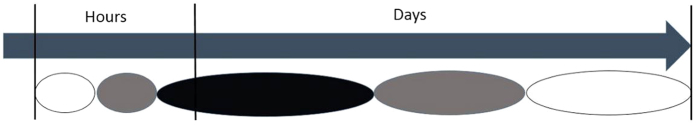
Possible evolution of hematoma in T2-weighted image.